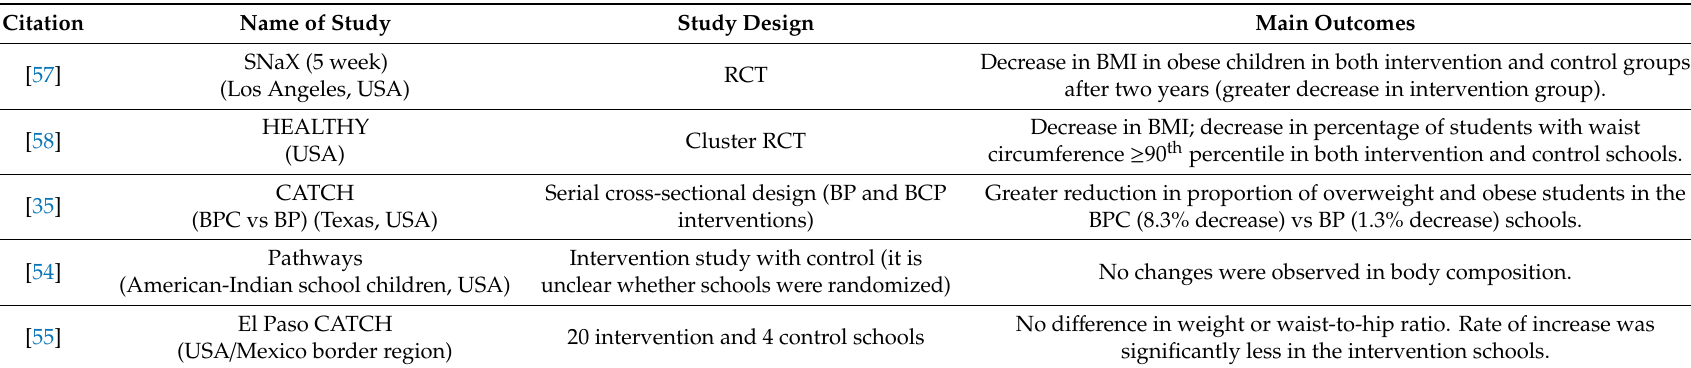
Table 2. Anthropometric outcomes of nutritional intervention studies that took place in schools since 2000. Findings are presented in chronological order, with the most recent publications listed